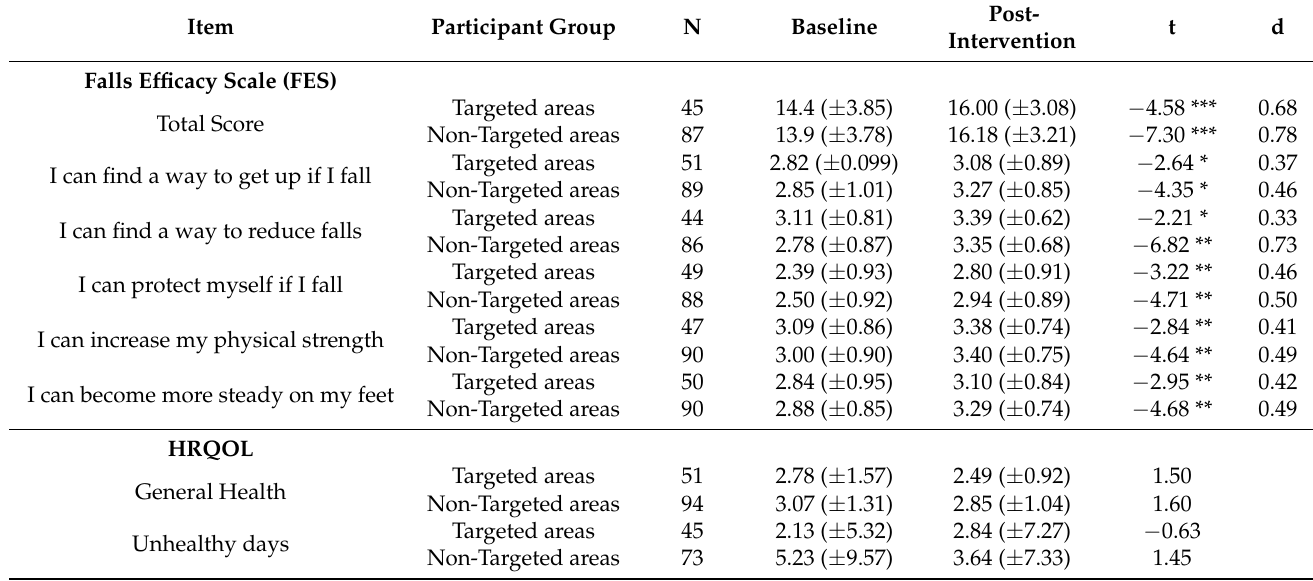
Table 4. Results of the paired sample t -test for healthy days and falls efficacy